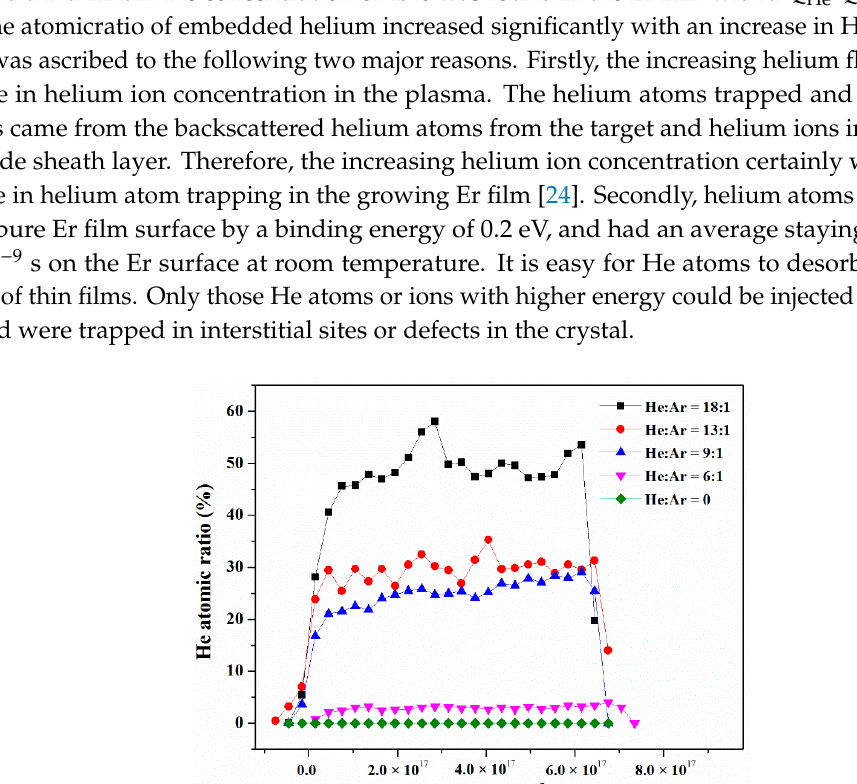
recoil detection analysis (ERDA).